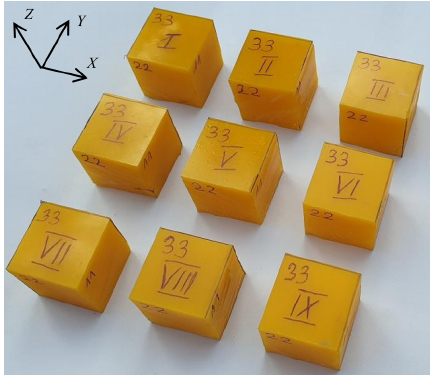
Figure 5. Viscoelastic material samples for compression test.